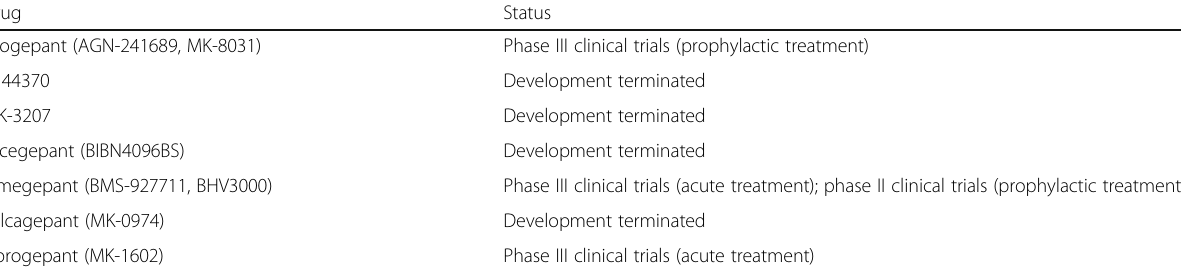
Table 2 Overview of gepants for the treatment of migraine in alphabetical order Drug Status Atogepant (AGN-241689,